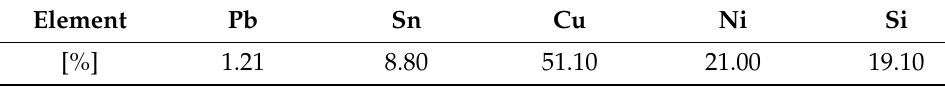
Table 4. Result of the wet chemical analysis of the silicide